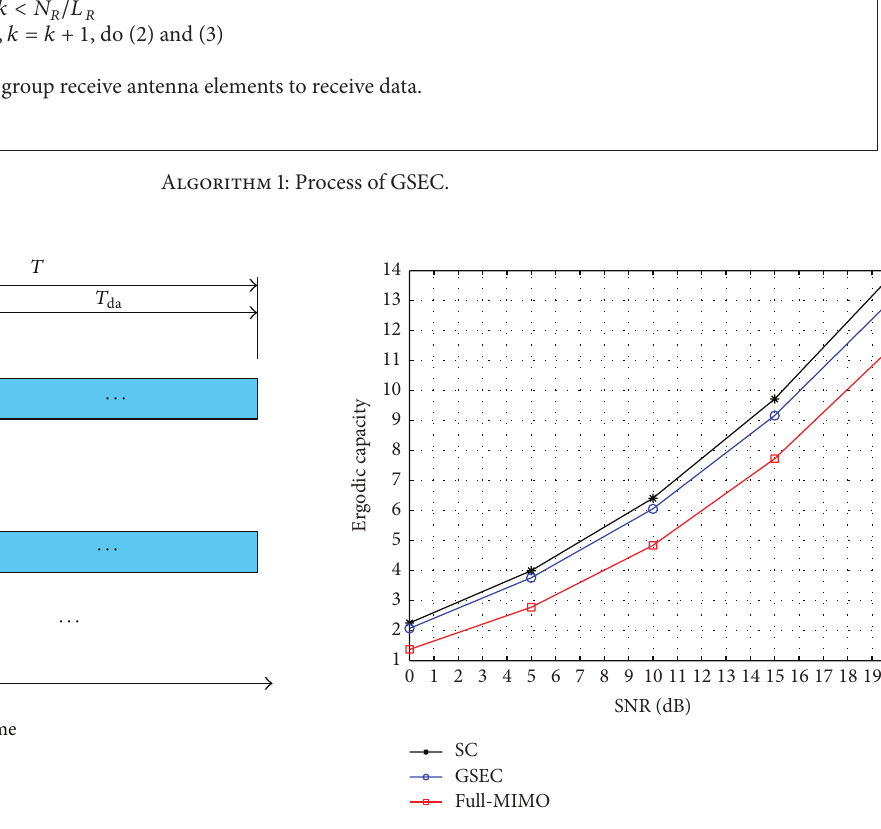
Figure 7: Effective ergodic capacity when 𝑇/Δ = ∞ ( 𝑁 𝑇 = 4 , 𝑁 𝑅 = = 4 , 𝐷 = 𝐷 = 𝜆 20 , 𝐿 𝑅 𝑇 𝑅